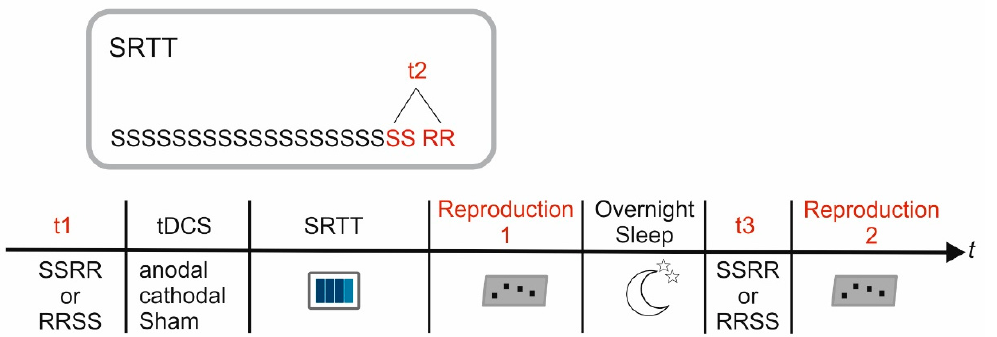
Figure 3. Study Design. Reaction times were analyzed at baseline prior to SRTT training (t1), at the end of the training block (t2) and after overnight sleep (t3). The insert indicates details of the SRTT: After 20 repetitions of the sequential pattern (S) 16 randomly varying stimuli (RR) were presented to estimate unspecific reaction time improvement. Explicit sequence knowledge was determined immediately after the end of SRTT training (reproduction 1) as well as after overnight sleep (reproduction 2).